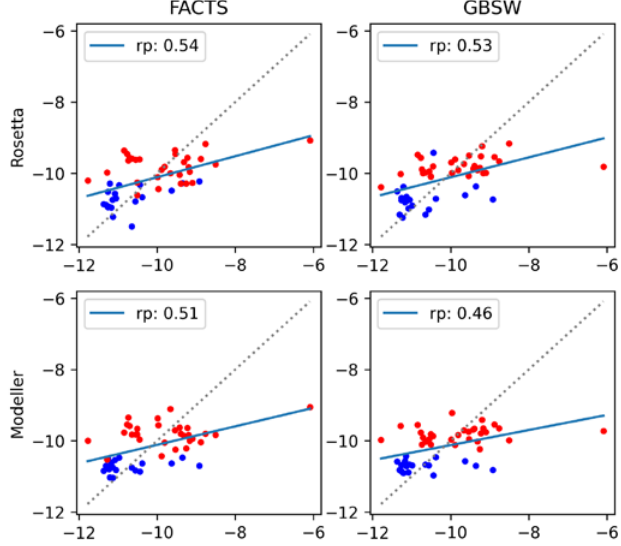
Figure 7. Correlation between experimental and computed binding affinities using the refitted MM- GBSA models. FACTS and GBSW implicit solvents correspond to the ( left) and ( right) columns, respectively; Rosetta and Modeller structures correspond to the ( top) and ( bottom) rows, respectively. Table 2. Fitted parameters (Equation (2)) and regression statistics for the four models generated by the GBSW and FACTS implicit solvents on the Rosetta and Modeller structures. The statistical uncertainty in the Pearson correlation coefficients is about 0.02, estimated from the leave-one-out error. Energies are expressed in units of kcal/mol.